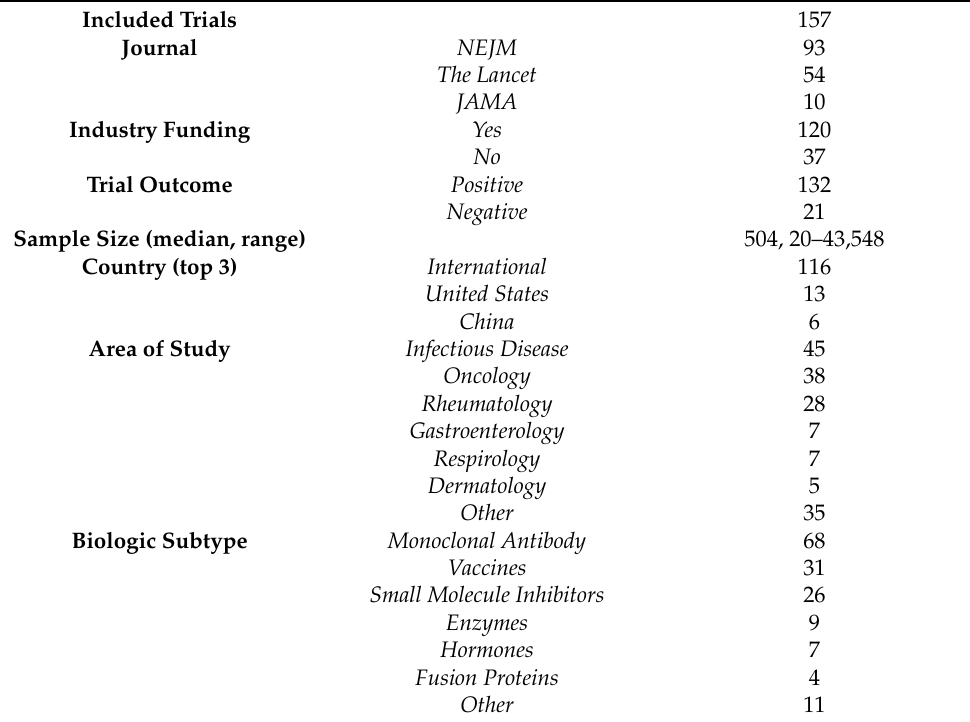
Table 1. Characteristics of included